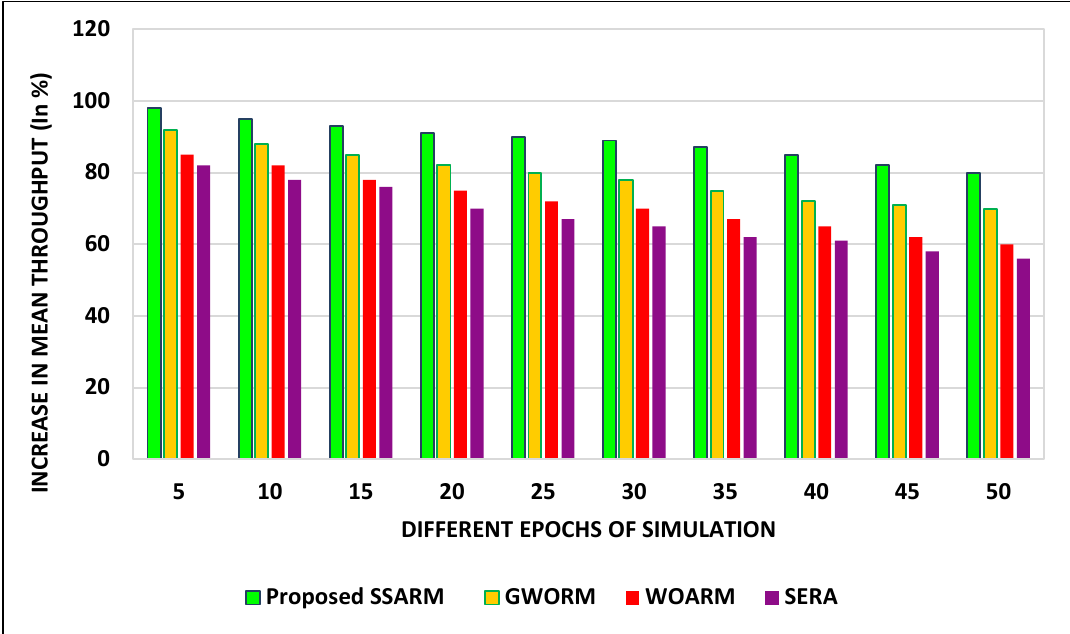
Figure 6. Proposed SSARM-Optimality in Resource Assignment with Different Epochs of